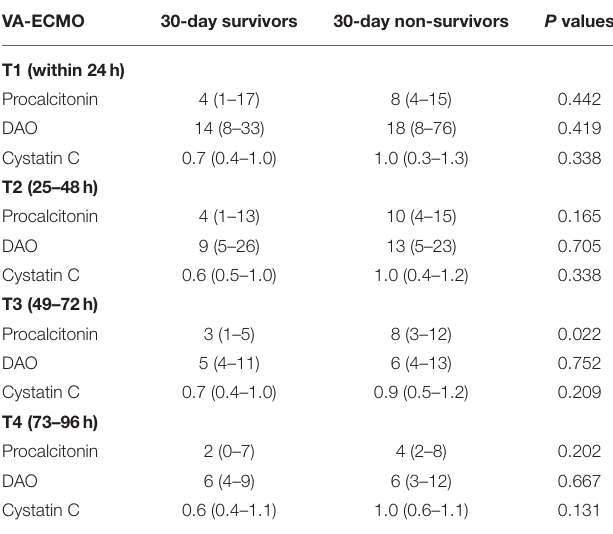
TABLE 4 | Data of VA-ECMO patients with or without elevated EAA levels at